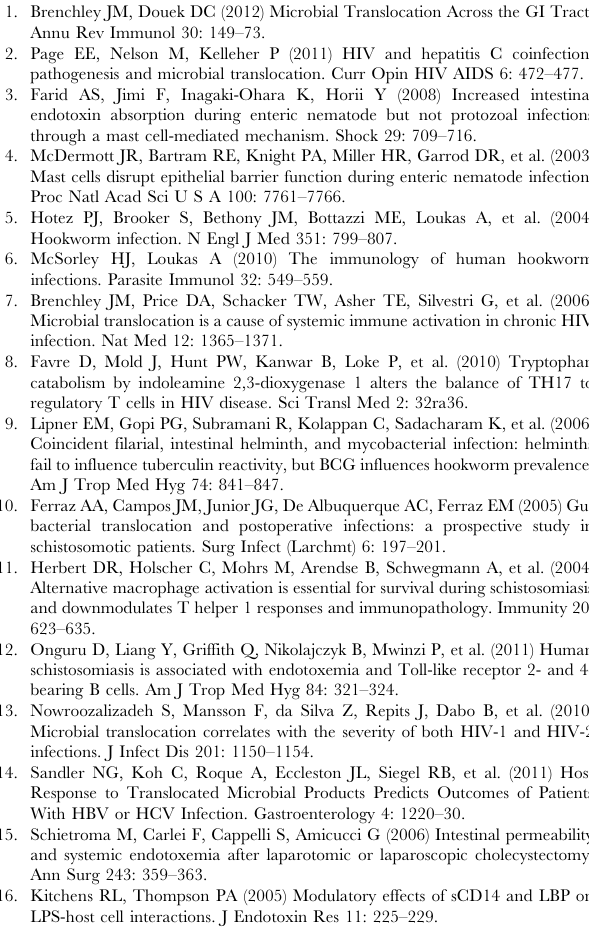
Figure S2 Gating strategy for estimating frequencies of dendritic cell (DC) subsets. A representative flow cytometry plot showing the gating strategy for estimation of plasmacytoid (pDC) and myeloid (mDC) dendritic cells from lineage-negative cells. pDC were classified as HLA-DR + CD123 + and mDC as HLA-DR + CD11c +